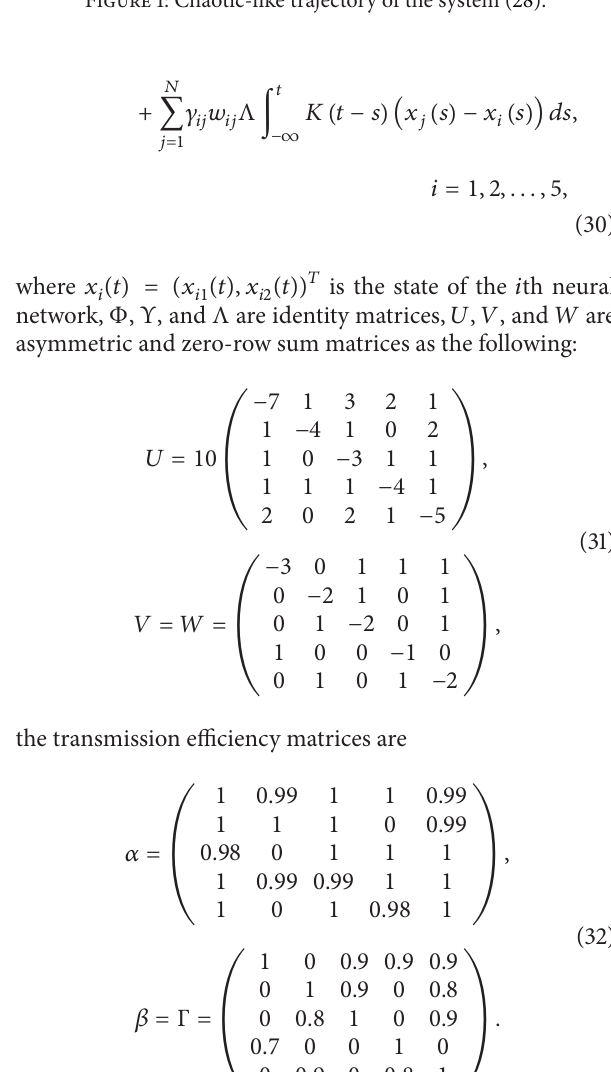
Figure 1: Chaotic-like trajectory of the system